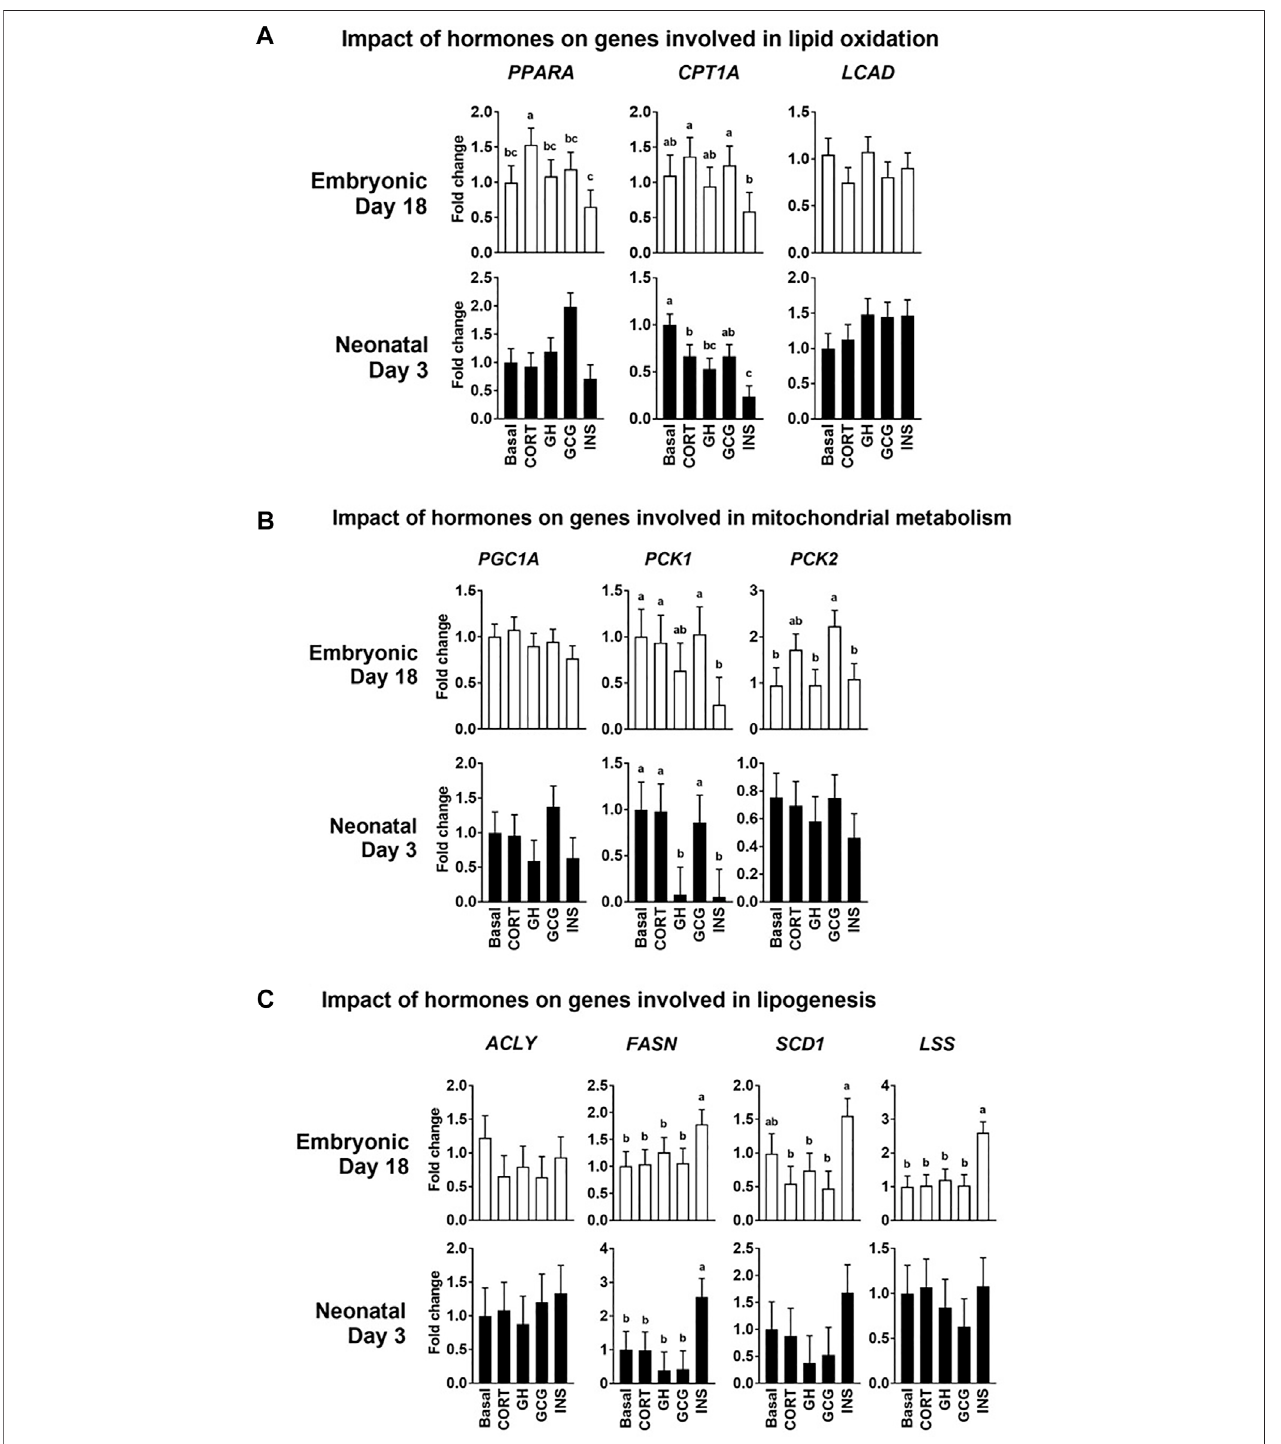
FIGURE 5 | Impact of the hormonal stimuli on hepatocyte metabolism. Quantitative PCR analysis was performed to determine the impact of four major hormones on hepatocyte metabolism. Fold changes in the expression patterns of genes involved in the regulation of (A) Lipid oxidation (B) Mitochondrial metabolism and (C) Lipogenesis in the liver were determined. All the values are Means ± pooled SE of four independent replicate experiments/age. Each independent replicate experiment was performed on pooled hepatocytes isolated from 2 – 3 birds. Results are considered signi fi cant at p ≤ 0.05 following one way ANOVA. Different superscripts between bars in a panel indicates statistical signi fi cance from other treatments. CORT, Corticosterone; GH, Growth hormone; GCG, Glucagon; INS, Insulin; PPARA , Peroxisome proliferator activator receptor 1a; CPT1A , Carnitine palmitoyl transferase 1a; LCAD , Long-chain fatty acyl, PGC1A , Peroxisome proliferator-activated receptor gamma coactivator 1-alpha; PCK1/2 , Phosphoenolpyruvate carboxykinase 1 and 2; ACLY , ATP citrate lyase; FASN , Fatty acid synthase; SCD1 , Steroyl-CoA desaturase; LSS , Lanosterol synthase.